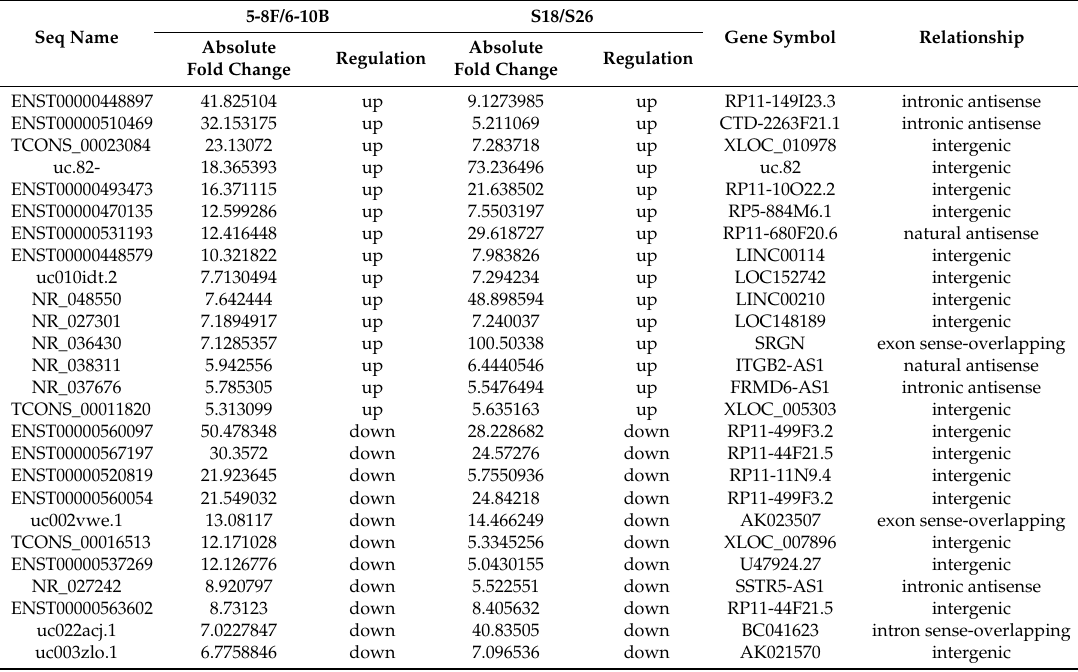
Table 1. Twenty-six significantly differentially expressed long non-coding RNAs (lncRNAs) in